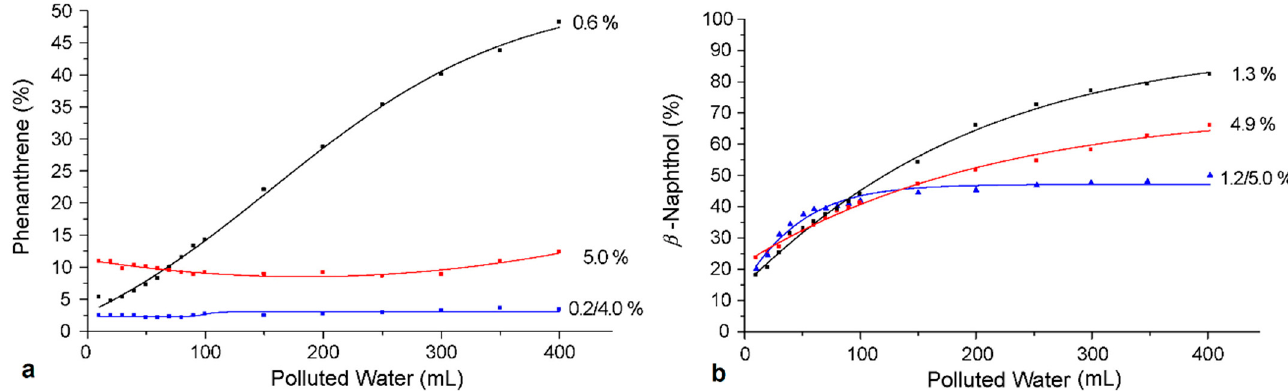
Figure 25. Percentage of phenanthrene ( a ) and β -naphthol ( b ) remaining in water in continuous filtration through filters impregnated by different percentages of octyl-substituted hyperbranched PEI employing a single or a two-step immersion stage (Reproduced with permission from [61]; Copyright Elsevier, 2008).